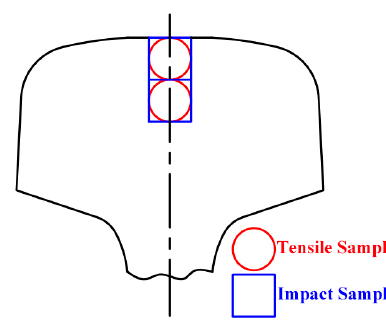
Figure 1. Schematic diagram showing the sampling positions in the rail-head.